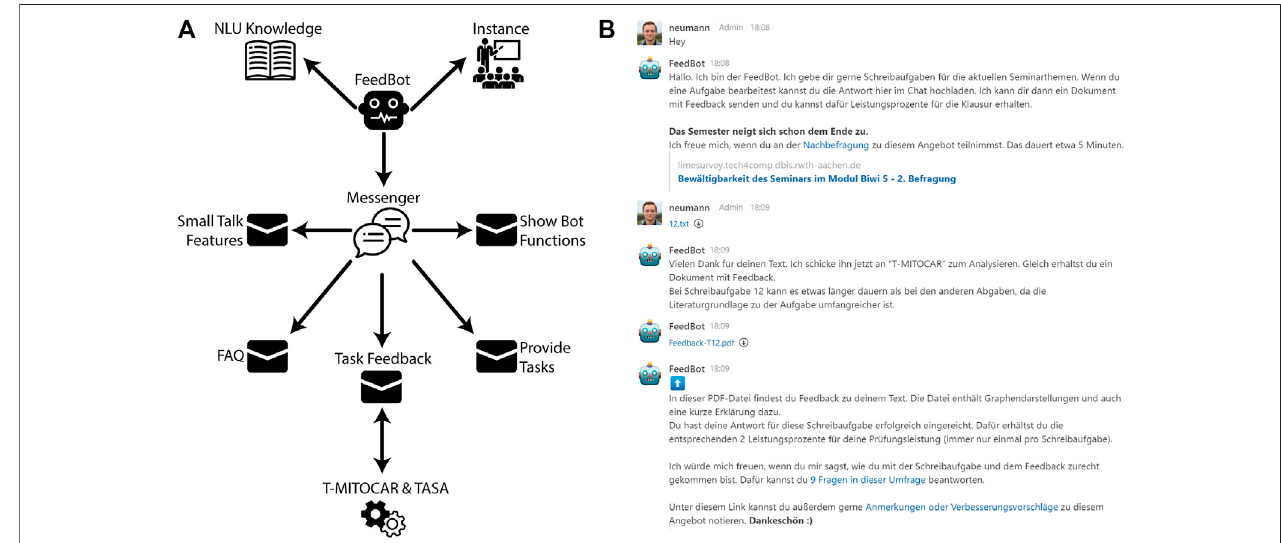
FIGURE 2 | (A) Simpli fi ed model of the FeedBot . Messages grouped by functional scope. (B) Rocket.Chat conversation with FeedBot (greeting, sending task submission and receiving